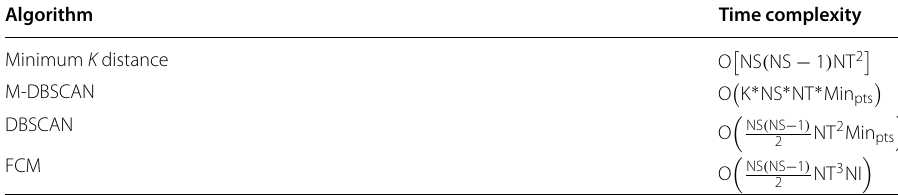
Table 3 The time complexity of algorithm